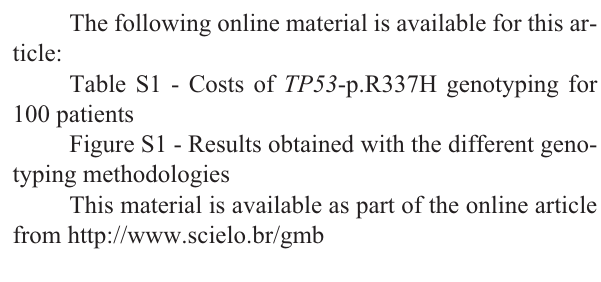
Table S1 - Costs of TP53 -p.R337H genotyping for 100 patients Figure S1 - Results obtained with the different